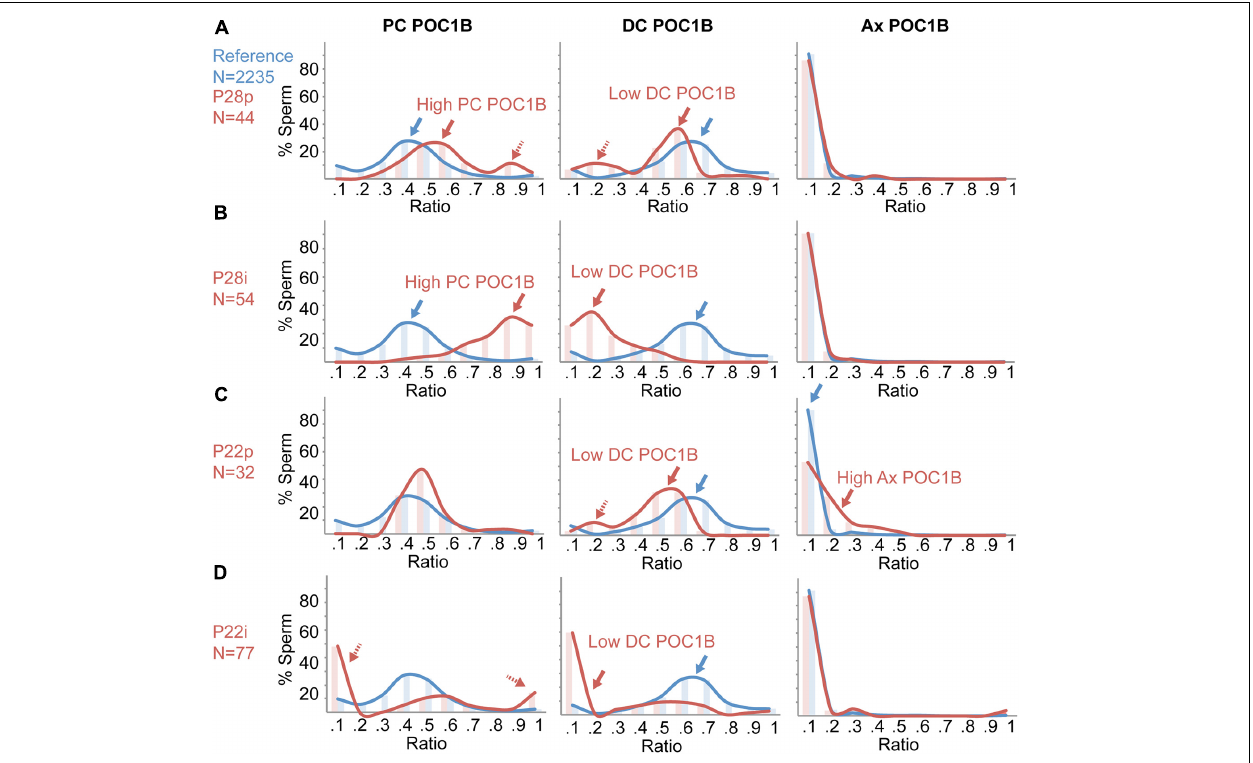
FIGURE 5 | Individual Sperm Ratio Distribution analysis provides additional insight into sperm centriole abnormalities. Histograms of the percent of individual sperm at different ratios of POC1B in the proximal centriole (PC), POC1B distal centriole (DC), and POC1B axoneme (Ax). Reference (blue) is the sperm of the 19 patients within the 22-patient reference population that have optimal centriole quality. (A) Ratios of 44 pellet sperm from a patient, P28p (red), that does not have teratospermia but was found to have suboptimal POC1B ratios in the PC and DC. (B) Ratios of 54 interface sperm from a patient, P28i (red), that does not have teratospermia but was found to have suboptimal POC1B ratios in the PC and DC. (C) Ratios of 32 pellet sperm from a patient, P22p (red), that has teratospermia and was found to have suboptimal POC1B ratios in the DC and Ax. (D) Ratios of 77 interface sperm from patient, P22i (red), that has teratospermia and was found to have suboptimal POC1B ratios in the DC. The histogram bins for the ratios on the x -axis are 0, –0.1, 0.1 –0.2, 0.2, –0.3, 0.3, –0.4, 0.4, –0.5, 0.5, –0.6, 0.6, –0.7, 0.7, –0.8, 0.8, –0.9, 0.9 –